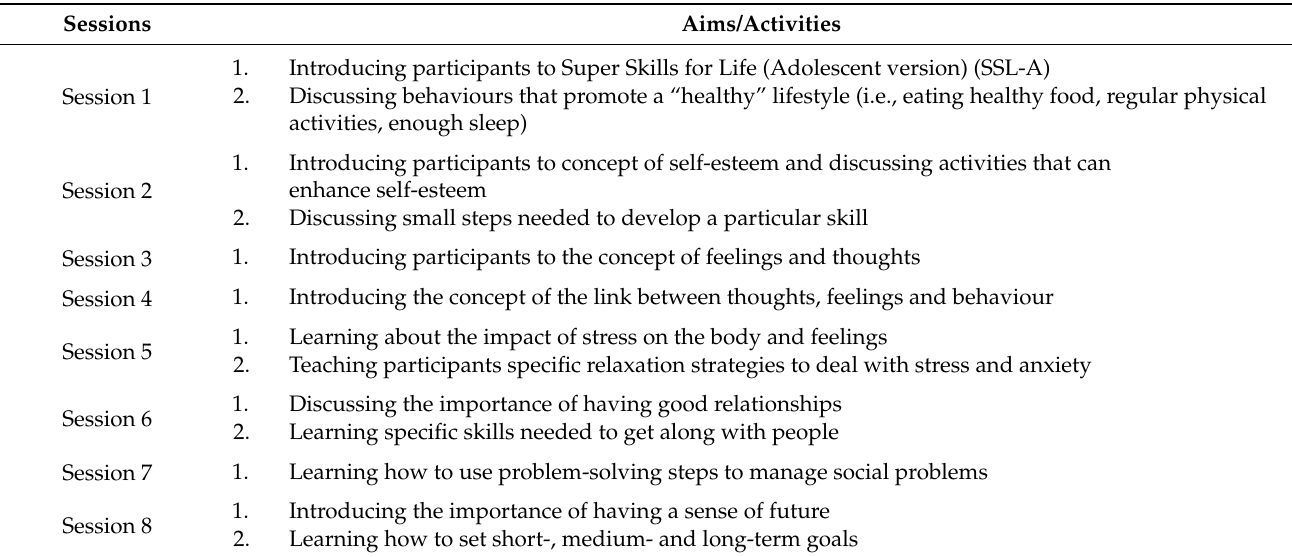
Table 1. The SSL programme modules and activity